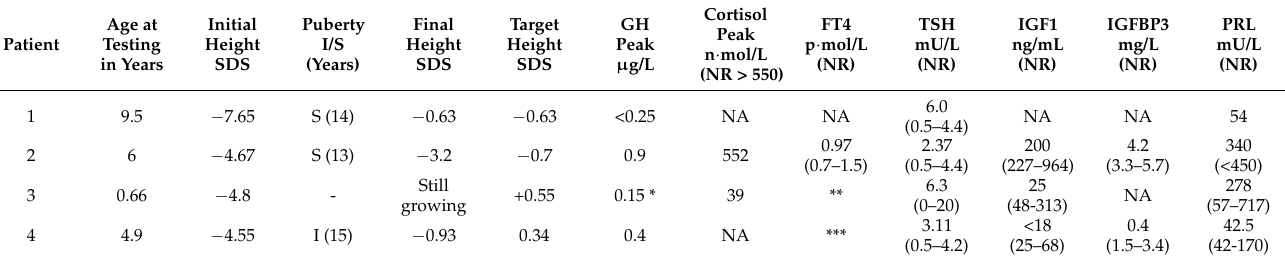
Table 1. Phenotype and endocrine investigations of